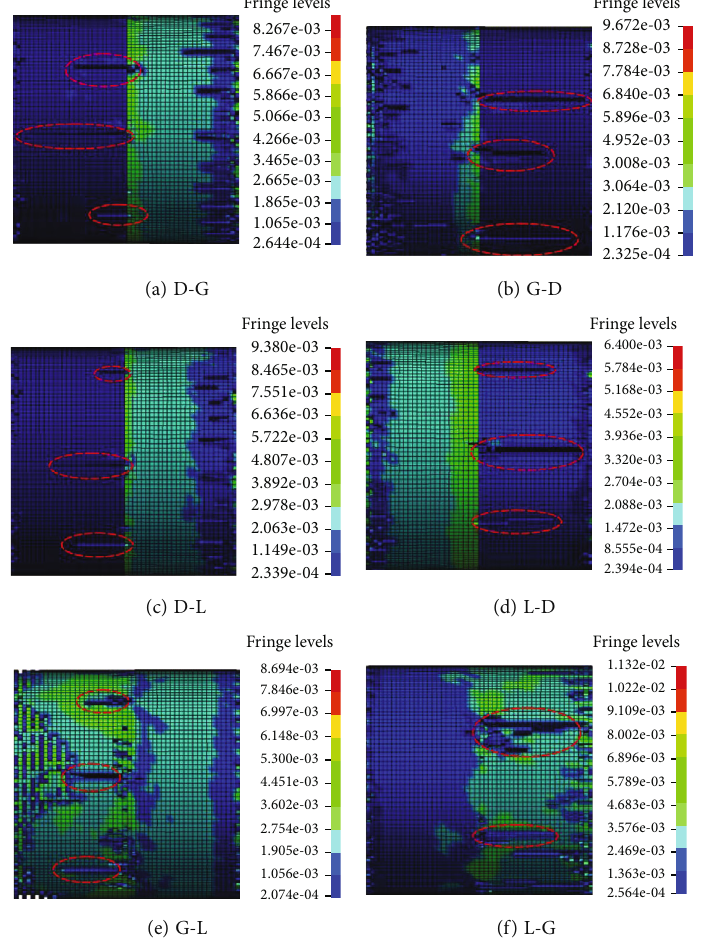
Figure 9: The initial failure state of the layered rock